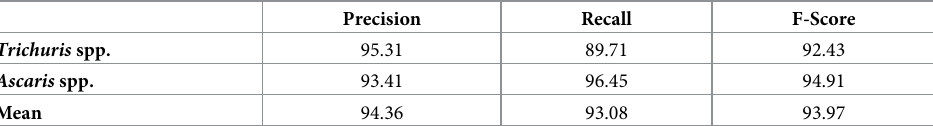
Table 3. Overview of the results obtained for the detection of helminth eggs from Trichuris spp. and Ascaris spp. Precision Recall